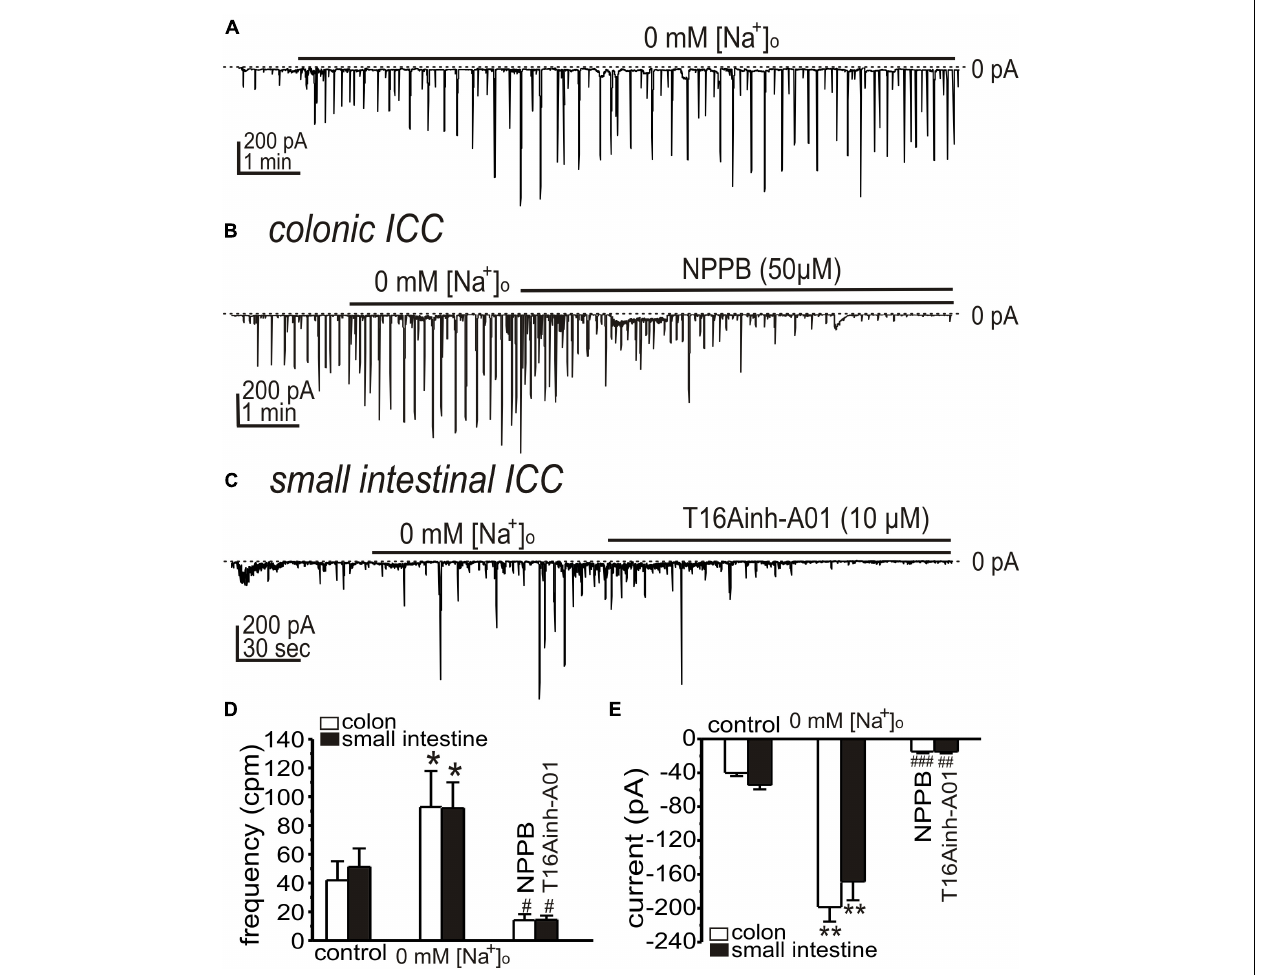
FIGURE 4 | Effects of Ca 2 + -activated Cl − channel (CaCC) blockers on STICs activated by low [Na + ] o in colonic and small intestinal ICC. (A–C) Representative traces showing increase in STICs in response to low external [Na + ] o (see Solution II). (A) Low external [Na + ] o increased STICs for the duration of the exposure (in this 10 min; small intestinal ICC). STICs were inhibited by CaCC blockers. (B) NPPB (50 µ M) inhibited STICs in colonic ICC held at –80 mV (Internal Solution V). (C) STICs were inhibited in small intestinal ICC by T16Ainh-A01 (10 µ M). Dotted lines denote 0 pA. (D,E) Summary data showing the effects of low [Na + ] o and Ano1 blockers on the frequency (D) and amplitude (E) of STICs (* p < 0.05, ** p < 0.01 vs. control; # p < 0.05, ## p < 0.01, ### p < 0.001 vs. low [Na + ] o